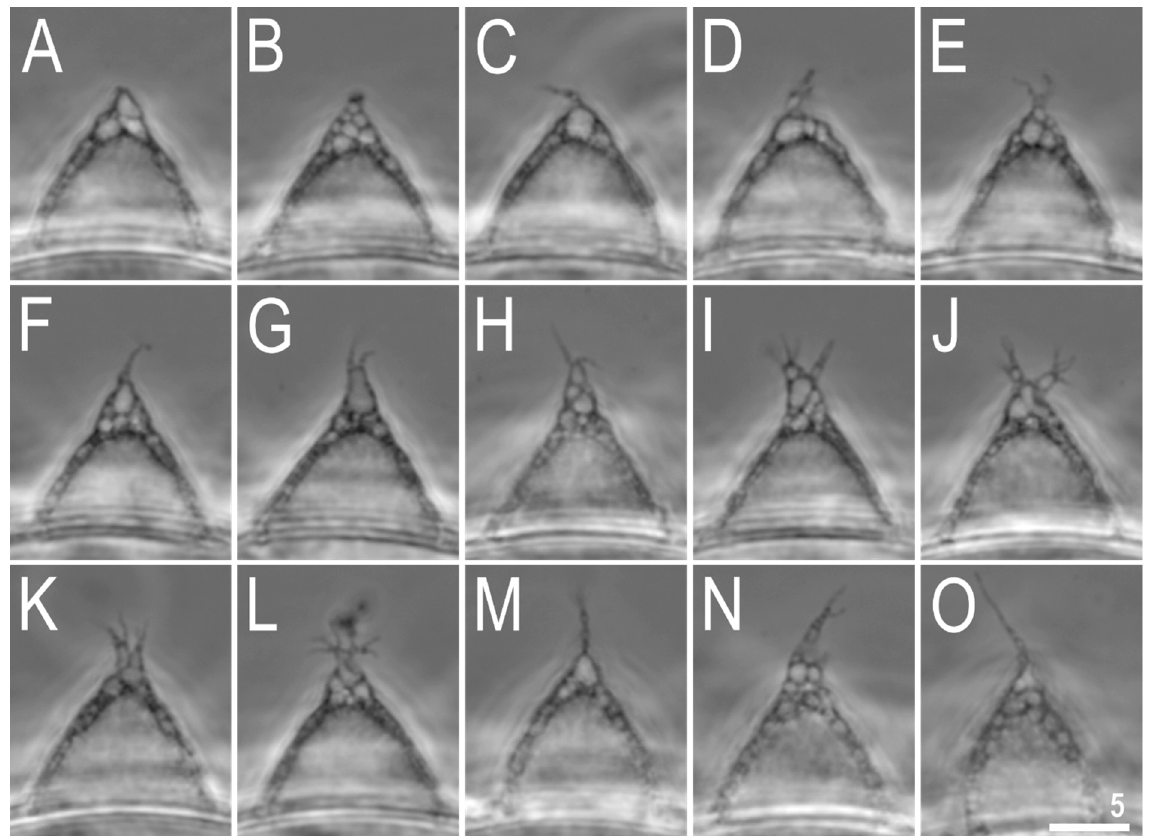
Figure 5. Mesobiotus imperialis sp. nov. —PCM images of the egg processes midsections under ×1000 magnification. Scale bar in μ m.